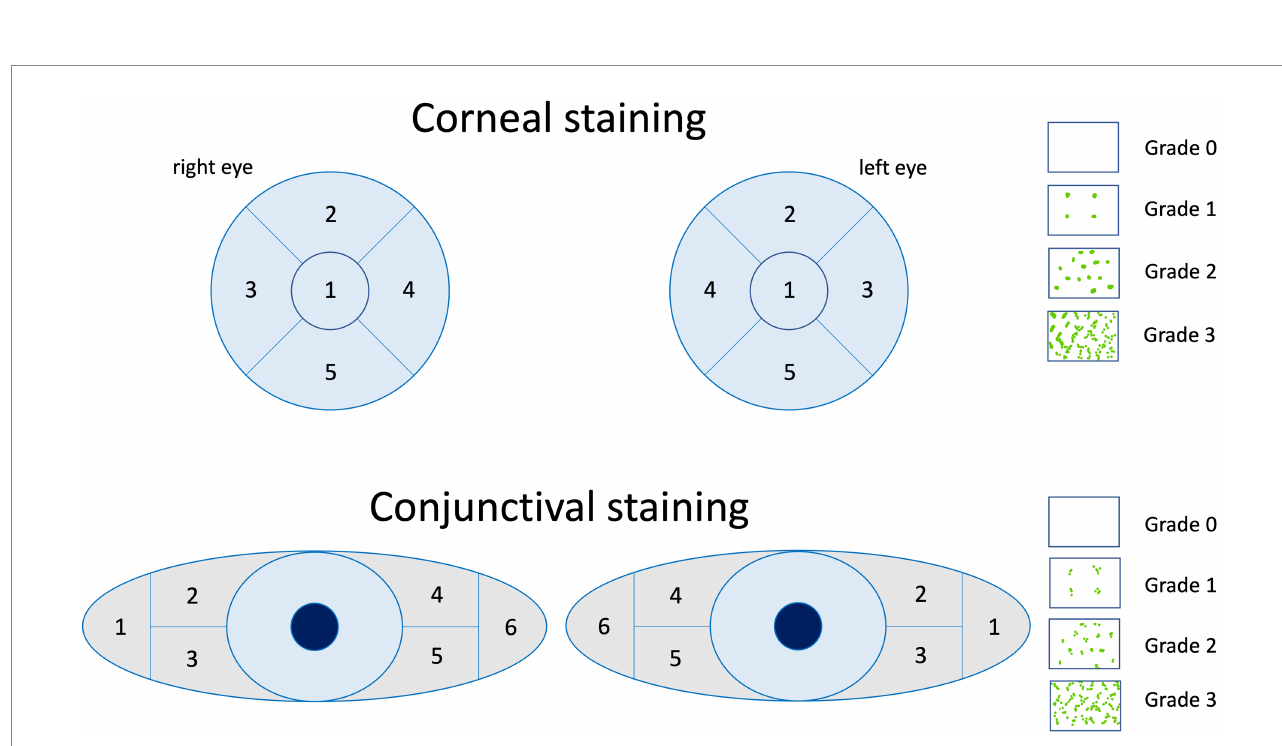
FIGURE 4 The NEI grading for corneal and conjunctival staining of the ocular surface is a standardized grading system that is summed up by the grading of 0 to 3 of each sector. Image adapted from Lemp et al.